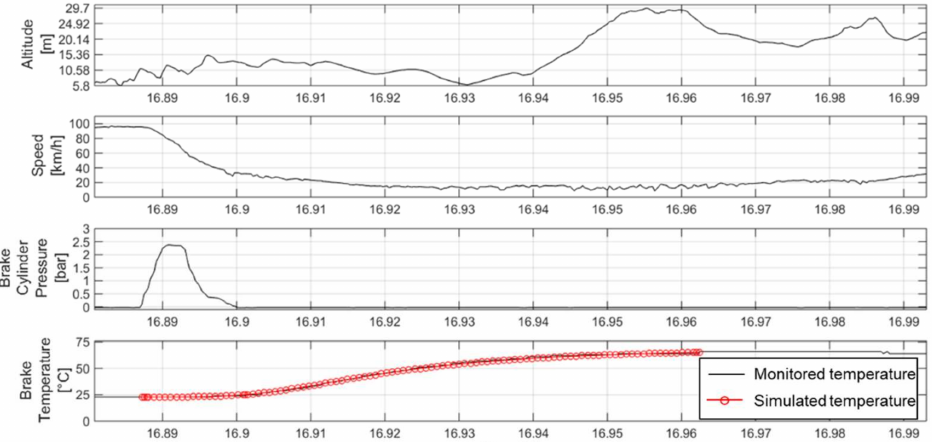
Figure 6. Braking maneuver A—Comparison of measured and simulated temperature of the brake block at the position where the sensor is installed.